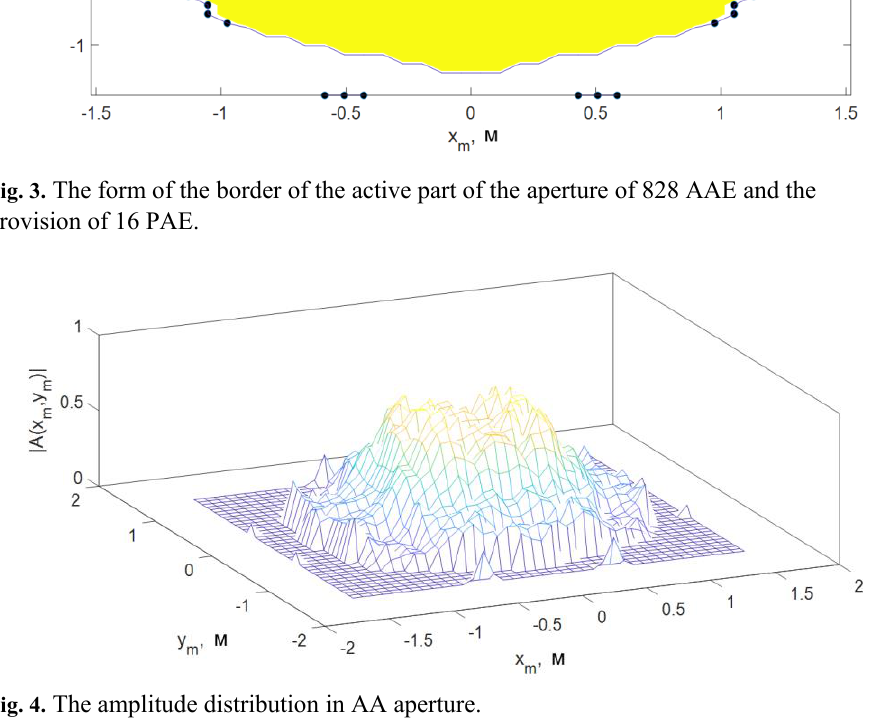
Fig. 4. The amplitude distribution in AA aperture.